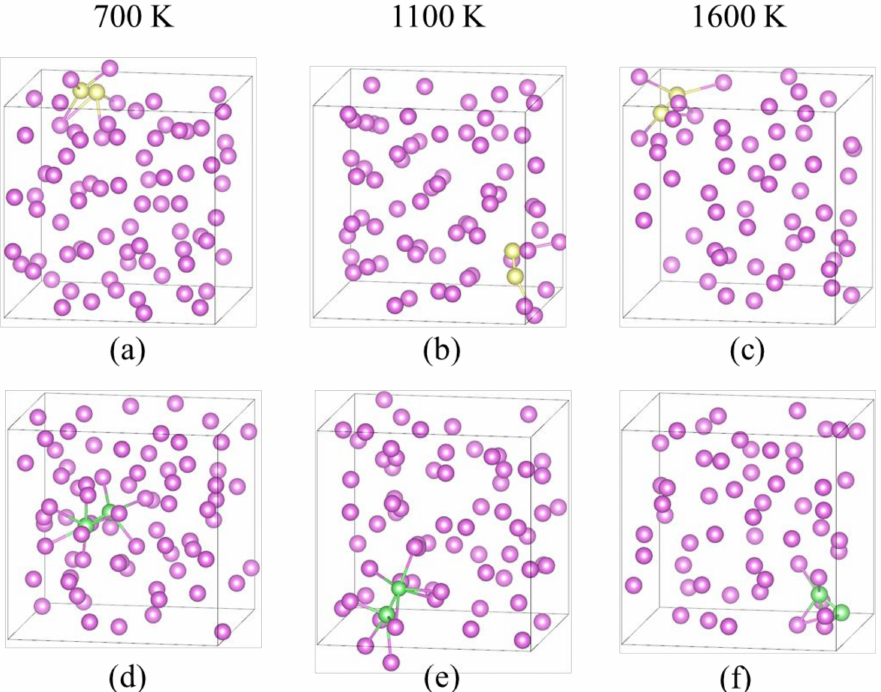
Figure 3. Snapshots of two solute atoms (1 mol/L) in liquid Na at different temperatures after 60 ps AIMD simulation: ( a – c ) Mo atoms in liquid Na at 700 K, 1100 K and 1600 K, respectively; ( d – f ) Re atoms in liquid Na at 700 K, 1100 K and 1600 K, respectively. Violet spheres, yellow spheres and green spheres represent Na atoms, Mo atoms and Re atoms, respectively.